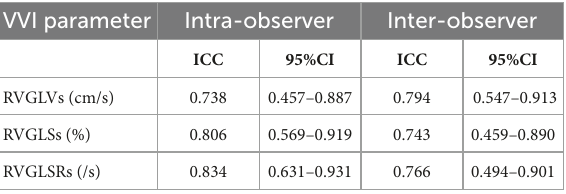
TABLE 7 Intraobserver and interobserver ICCs and 95% CI for right ventricular deformation parameters. VVI parameter Intra-observer